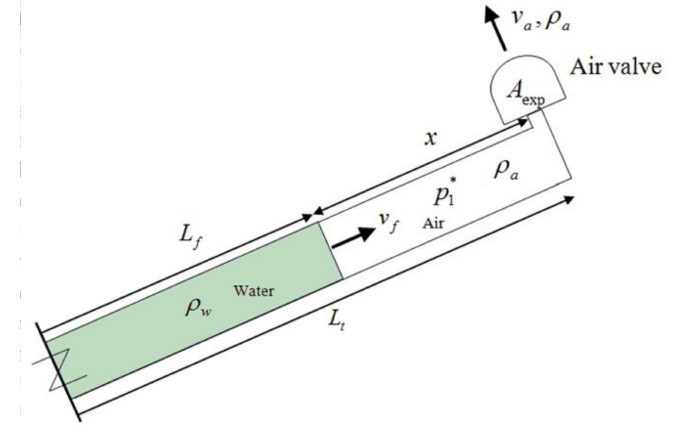
Figure 2. Location of the air